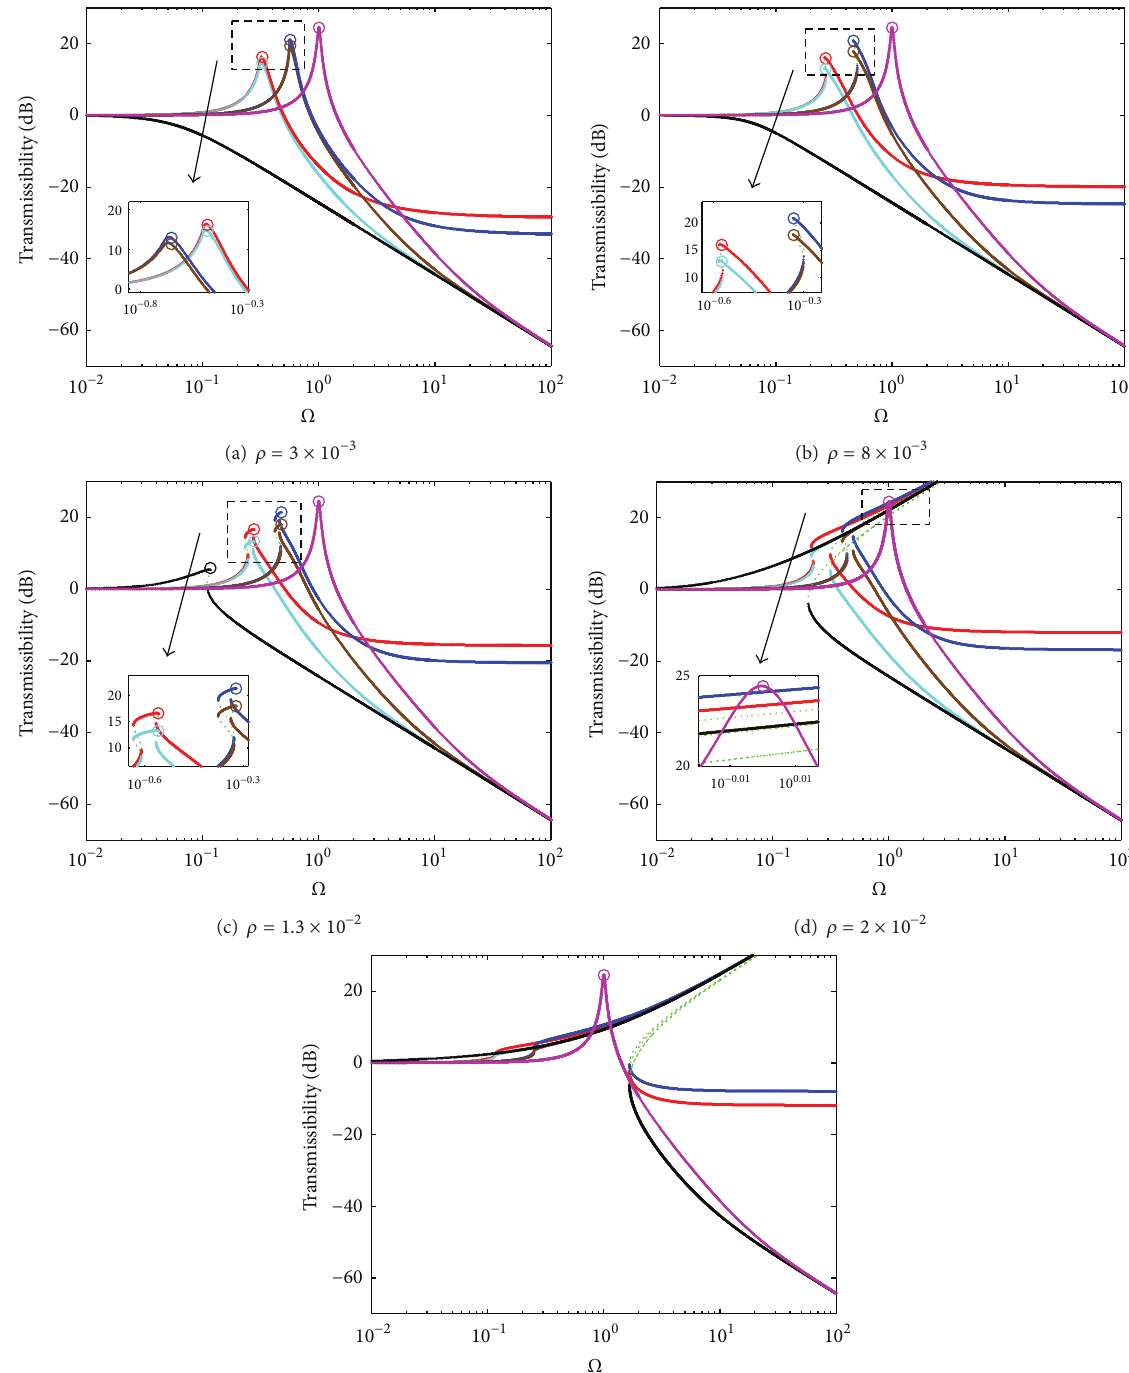
Figure 14: Absolute displacement and acceleration transmissibilities of the QZS isolator and ELS with different offset displacements and excitation amplitudes for the displacement excitation. “Red line” absolute displacement transmissibility of the disturbed isolator with ̂𝑢 = 0.04 ; “cyan line” absolute acceleration transmissibility of the disturbed isolator with ̂𝑢 0 = 0.07 ; “brown line” absolute acceleration transmissibility of the disturbed isolator with ̂𝑢 = 0.07 ; “black line” the ideal isolator; “magenta line” ELS; “green dotted line” unstable solutions; “o” peak amplitude of 0